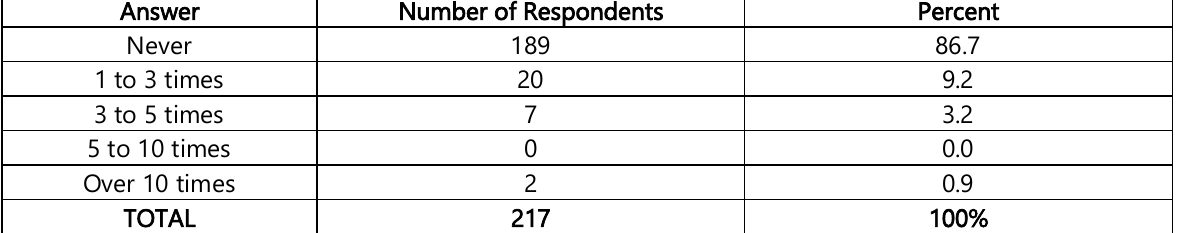
Table 2: Overview of the Level of Notification or Reporting for Possible Fiscal Evasion (Source: Authors’